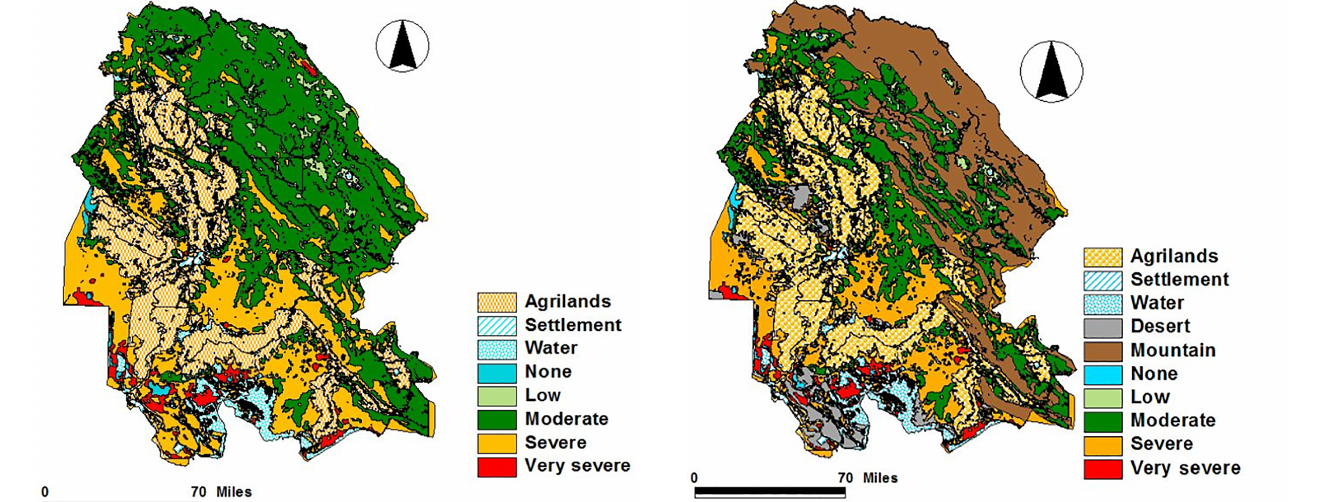
Figure 2. Map of the current state of land degradation in the study area.